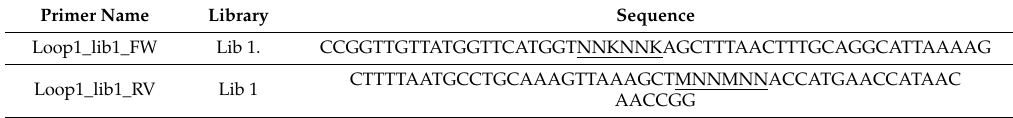
Table A1. Degenerate primers used to generate the deletion / randomization libraries of the bsla g ene. Primers pET_T7_HisC_FW and pET_T7_HisC_RV were used to incorporate a C-terminal 6x histidine tag to BSLA and variant P5F3. Randomized nucleotides are